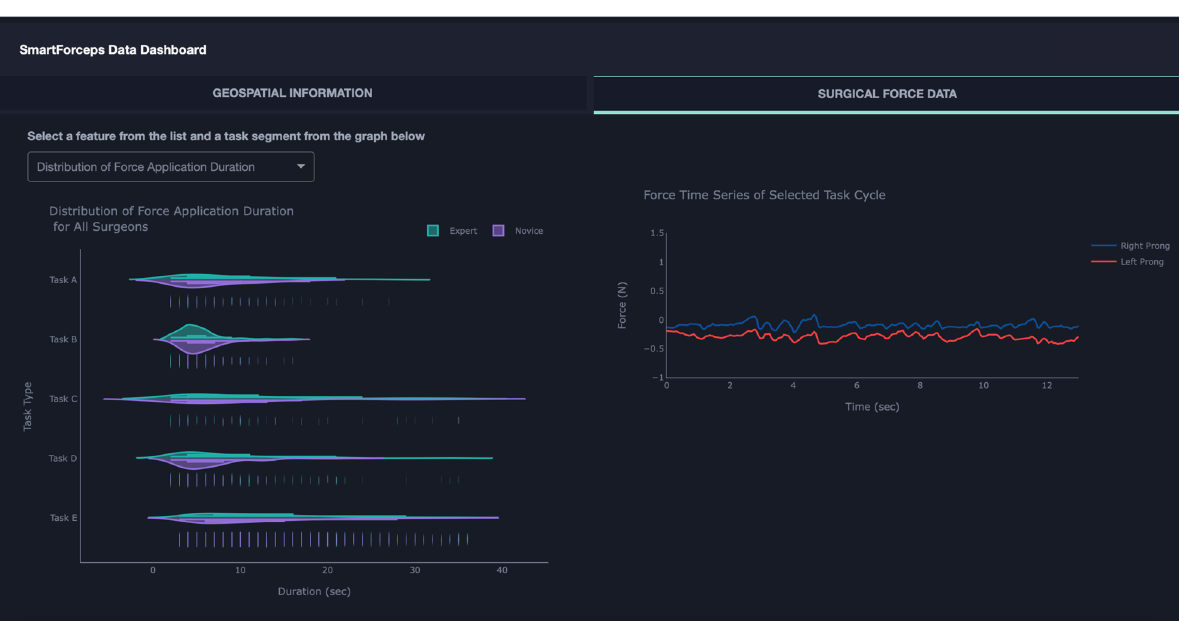
Figure 3. SmartForceps Data Analytics Dashboard in "General" view shown in a desktop mode. The current view includes two tabs of "Geospatial Information" ( a ) and “Surgical Force Data” ( b ). These charts have fully interactive capability including zoom, pan, download, etc. The figure for dashboard was created by Python Dash library version 0.43.0: https:// plotly. com/